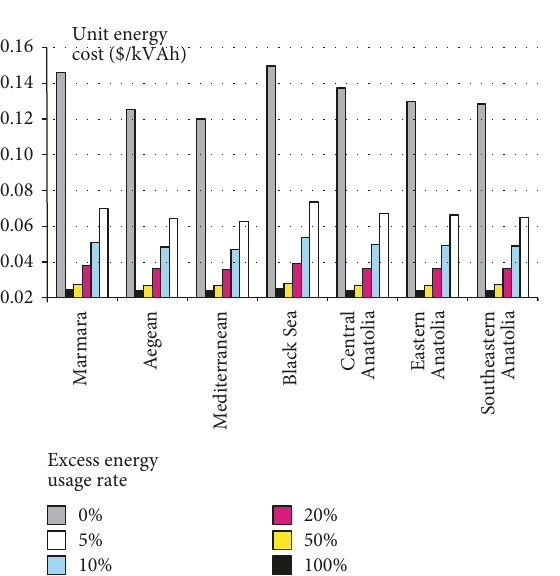
Figure 7: E ff ect of using excess energy on UEC in the all-year